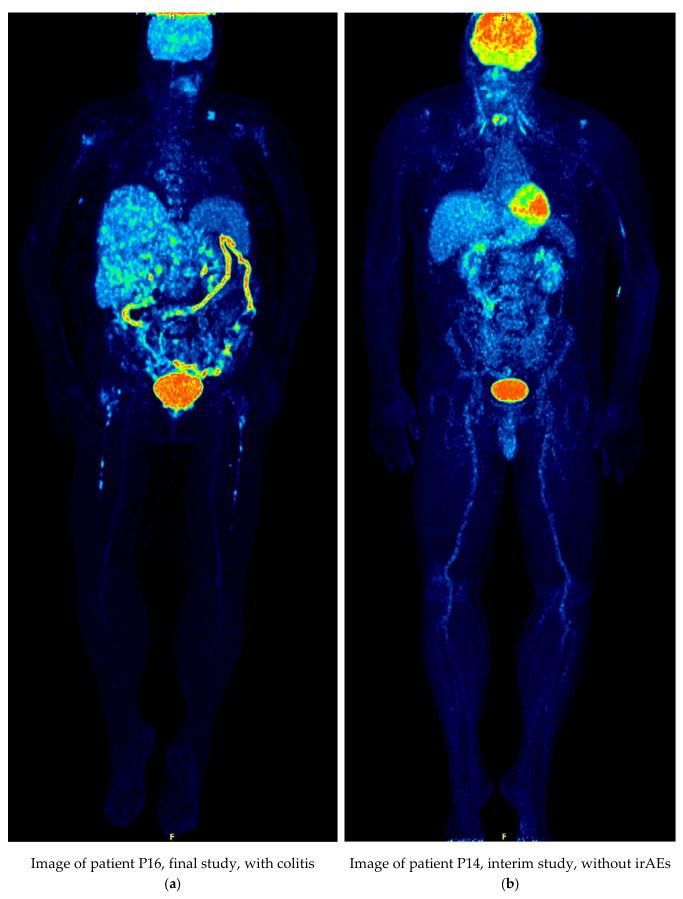
Figure 3. MIP PET-CT images for patients with metastatic melanoma: ( a ) Patient P16 at final stage with signs of colitis; ( b ) Patient P14 at interim stage without irAEs effects.